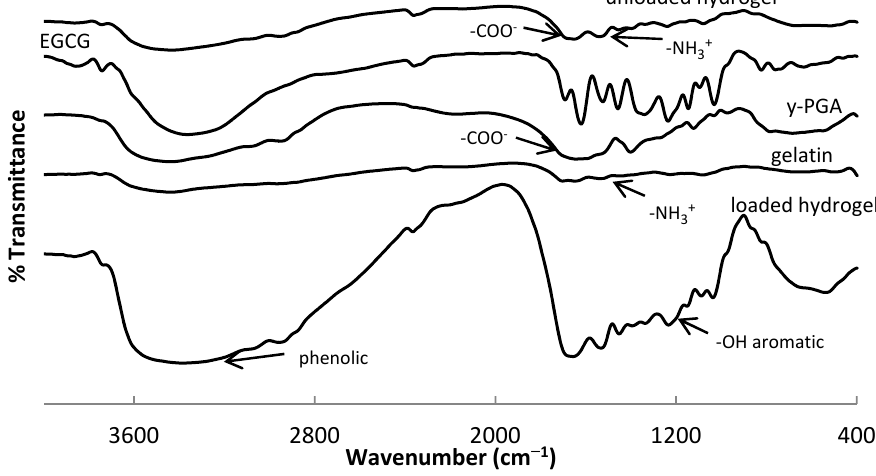
Figure 4. FT-IR spectra of extracted epigallocatechin gallate (EGCG) (65% purity), type-A gelatin, γ -PGA, freeze-dried, unloaded hydrogel (10%-gelatin, 1%- γ -PGA